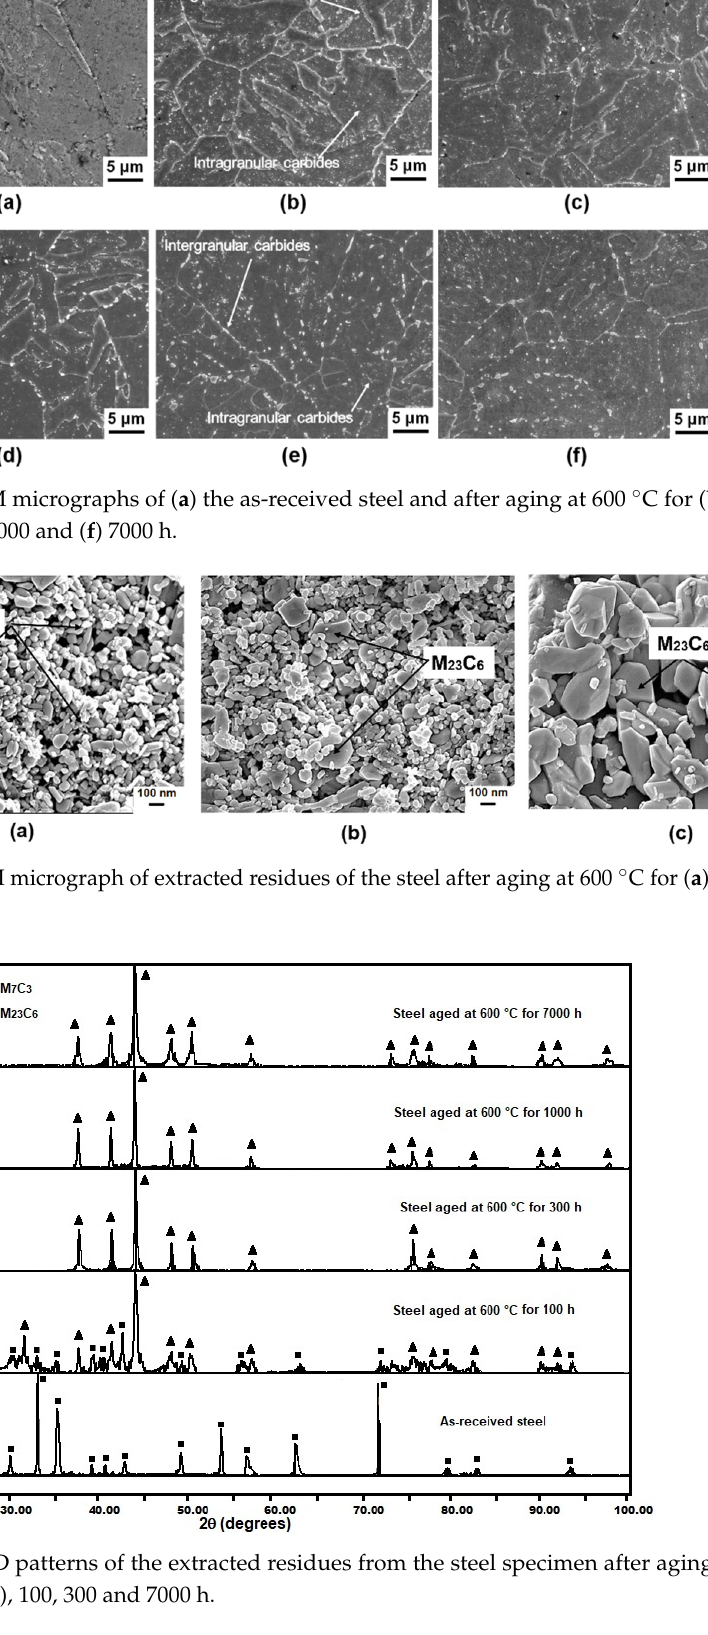
Figure 6. XRD patterns of the extracted residues from the steel specimen after aging at 600 °C for 0 (as-received), 100, 300 and 7000